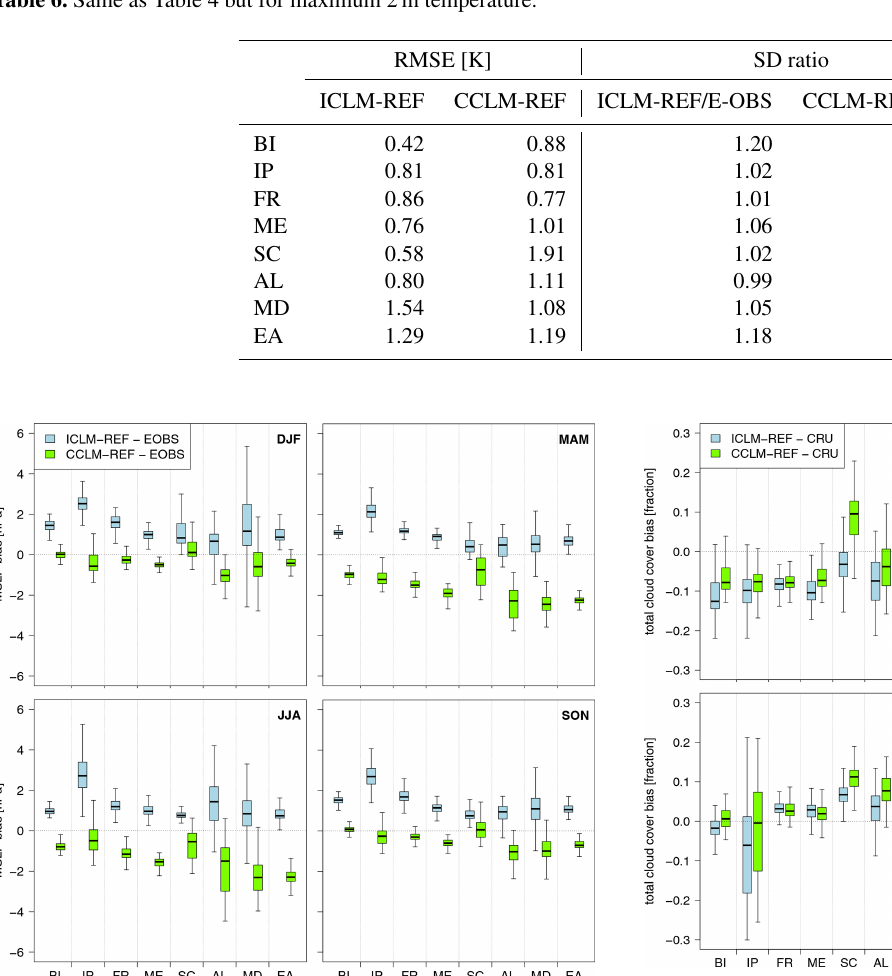
Table 6. Same as Table 4 but for maximum 2m temperature.